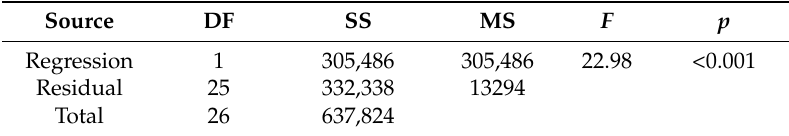
Table 3. Linear regression analysis of variance for the plot of microbial biomass carbon as a dependent variable against soil organic carbon for